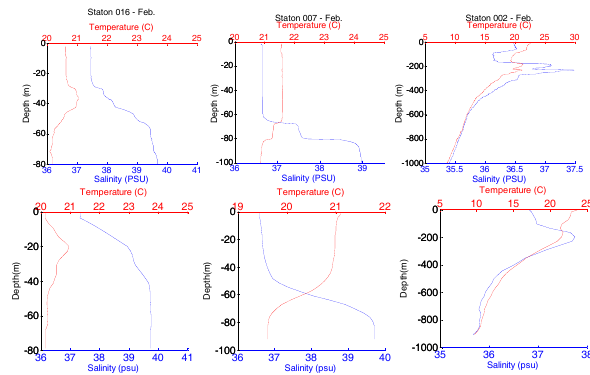
Fig. 6. Typical salinity- temperature profiles during February from CTD measurements (top) and model simualtions (bottom). Loca- tions are shown in Fig. 5.